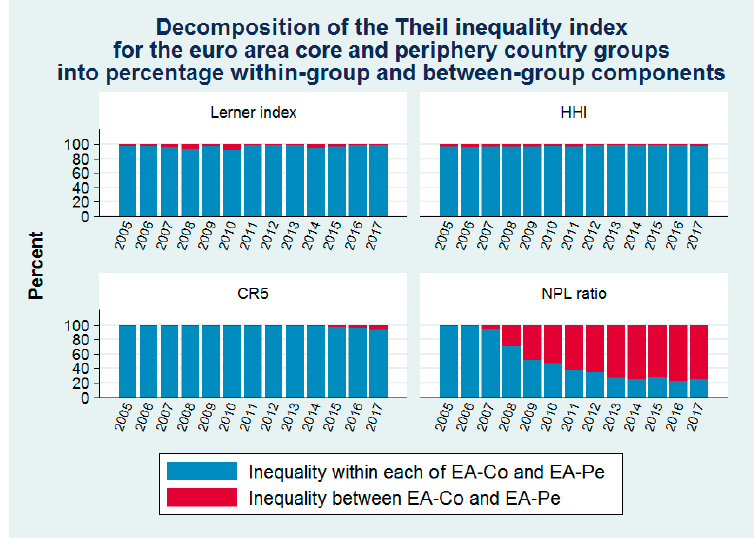
Figure 6. Decomposition of the Theil inequality index for the euro area core and periphery country groups into percentage within-group and between-group components. Source: BankScope database, ECB, World Bank, own calculations.